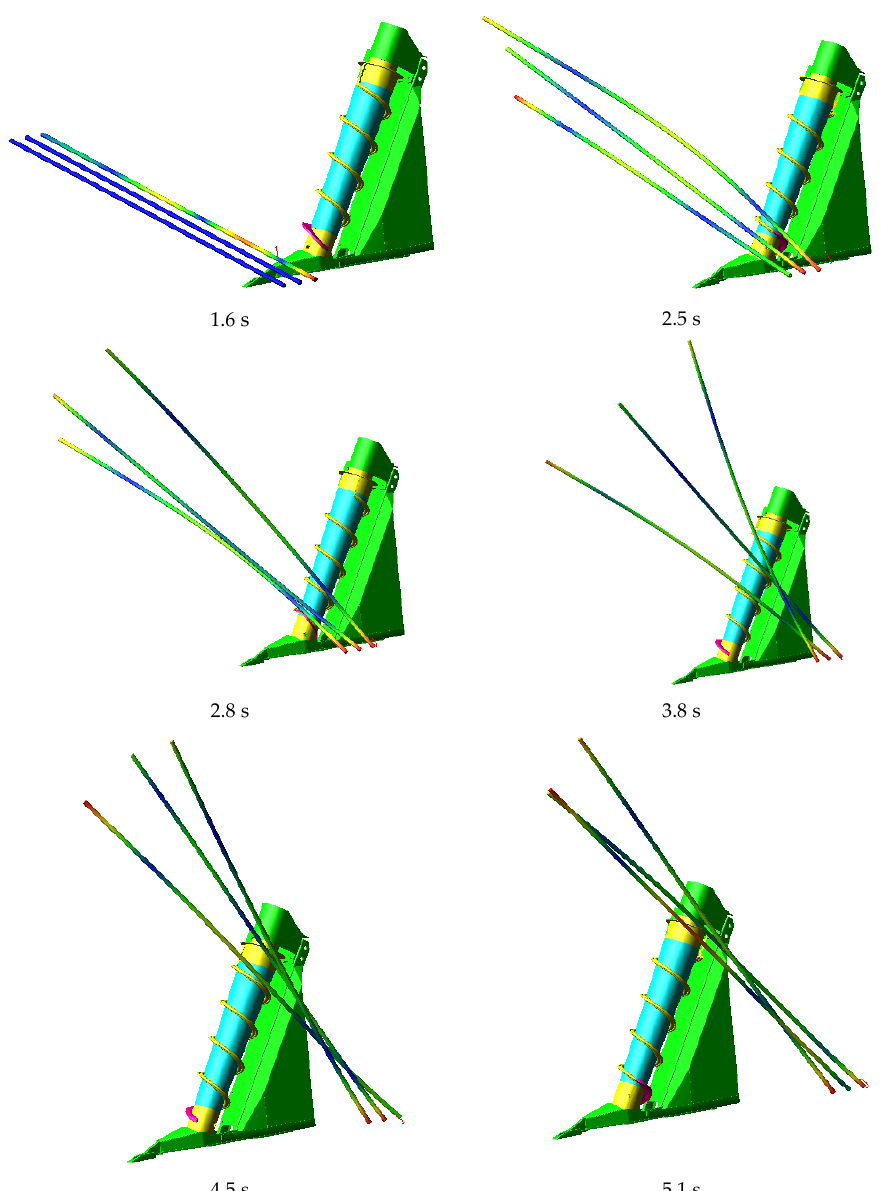
Figure 8. LS lifting